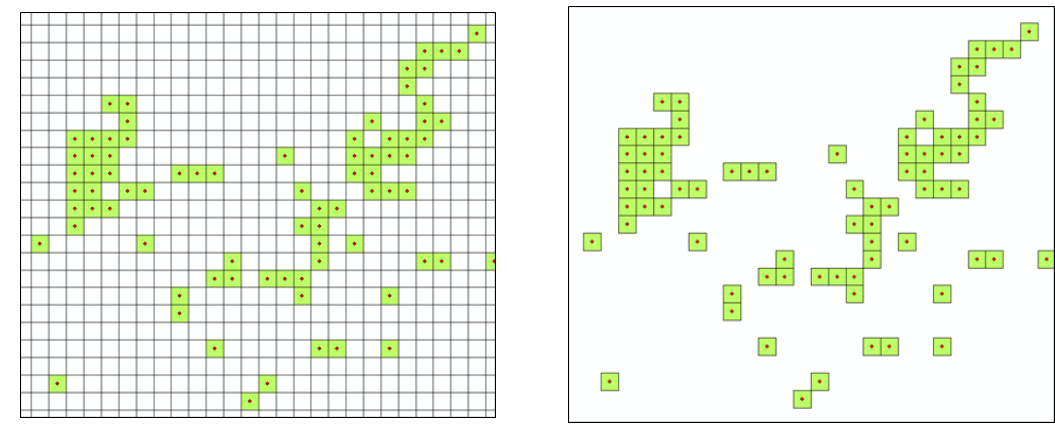
Figure 1. 100 m × 100 m grid, entire set of grids ( left ), a subset of the grids with residents ( right ).